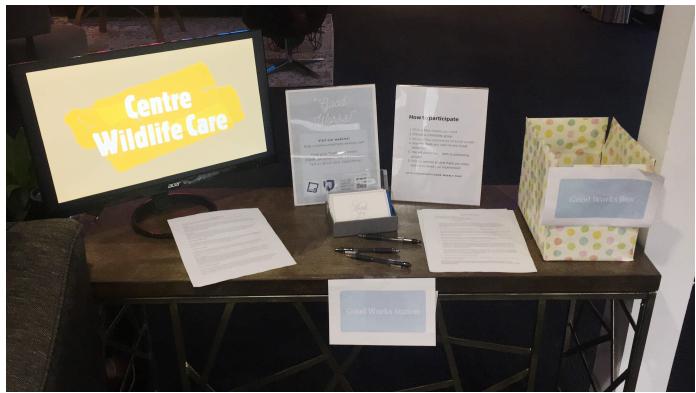
Figure 4. Public Thanking